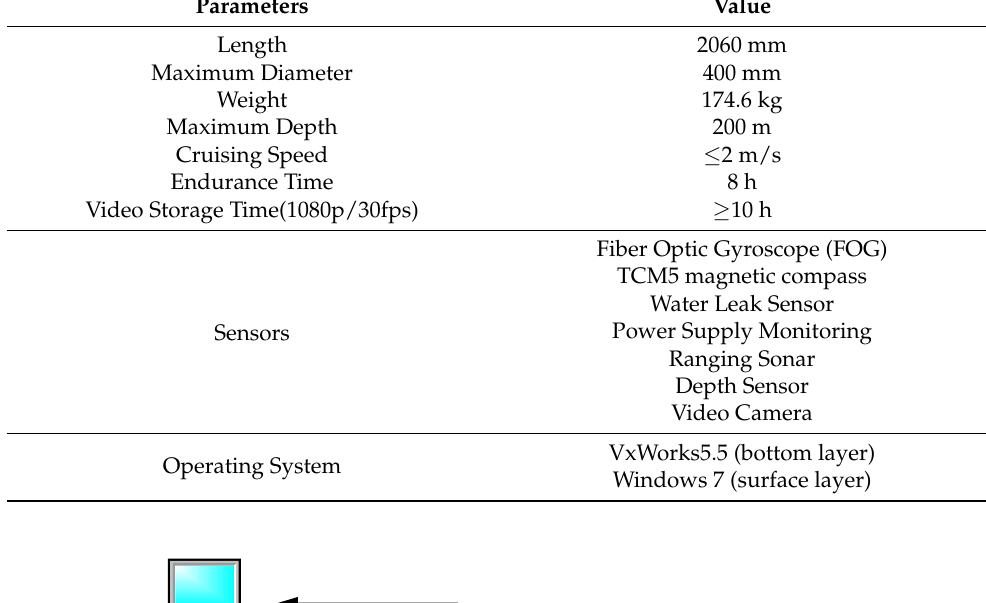
Table 1. Parameters of the AUV.